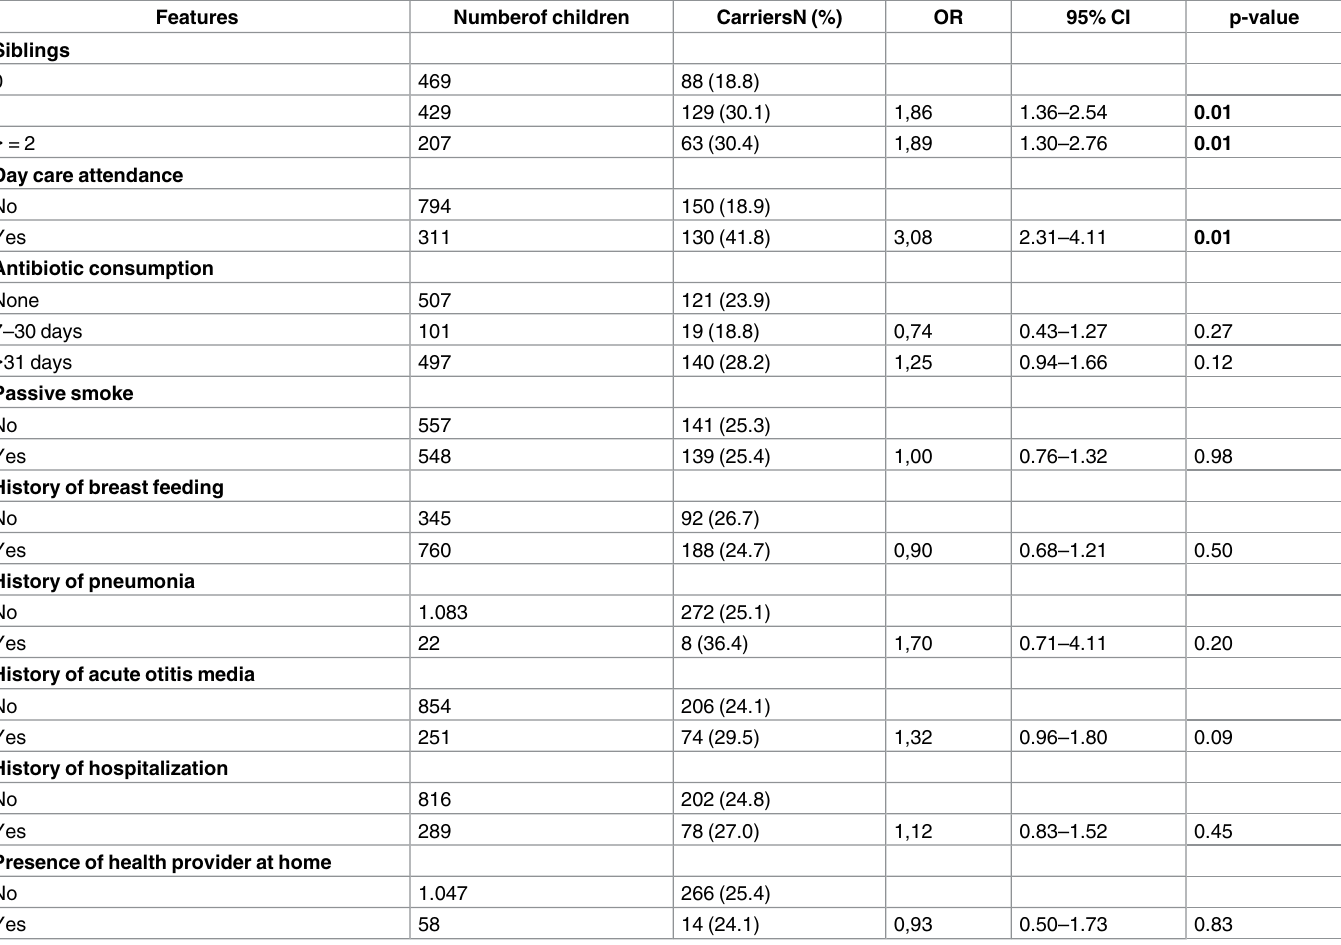
Table 2. Possible risk factors for Sp